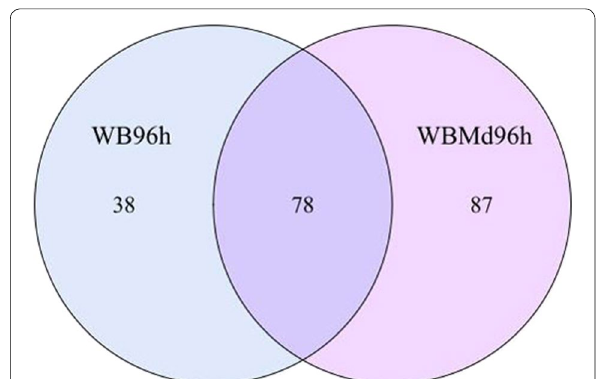
Fig. 3 Venn diagram of WB96h and WBMd96h samples at distance 0.03. The numbers represent the number of unique OTUs in each sample and common OTUs shared by the two samples. WB96h refers to the moistened wheat bran not treated with house fly larvae after 96 h. WBMd96h refers to the moistened wheat bran treated with house fly larvae for 96 h. Each treatment included three biological